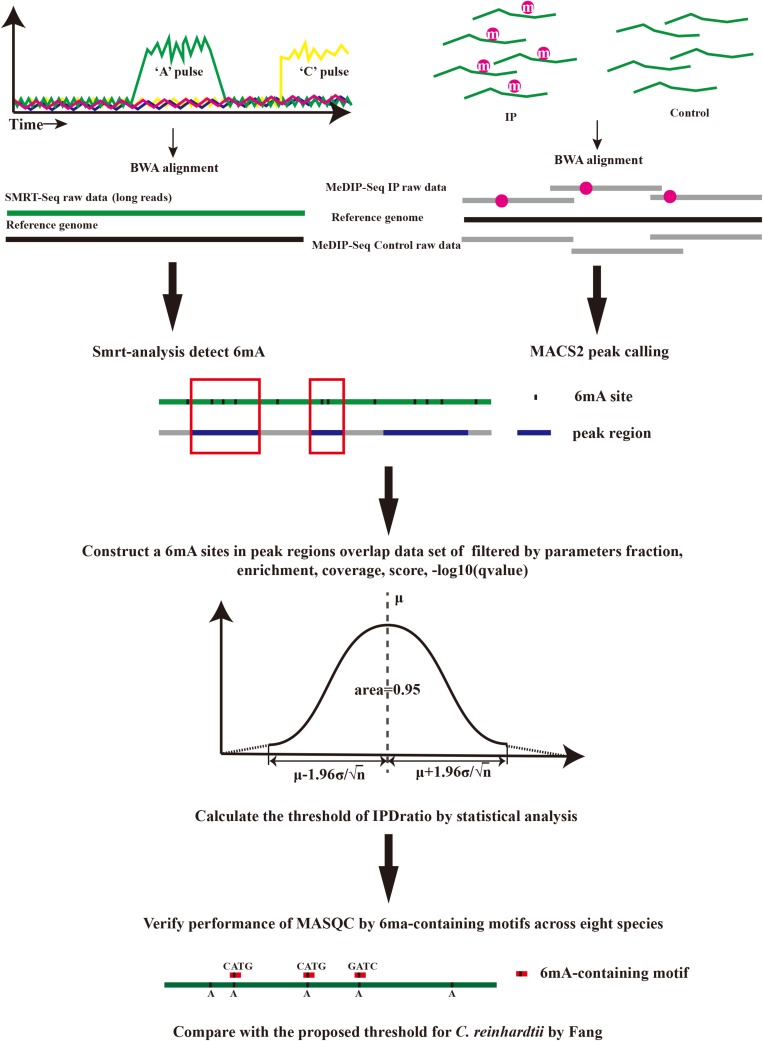
The overview of MASQC method.